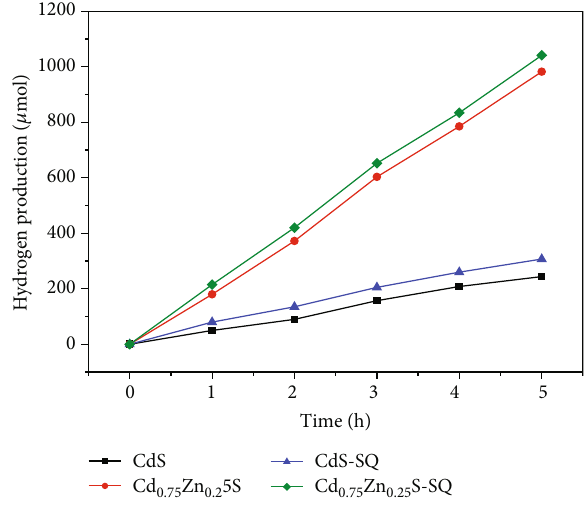
Figure 11: Performance in hydrogen production as a function of time.